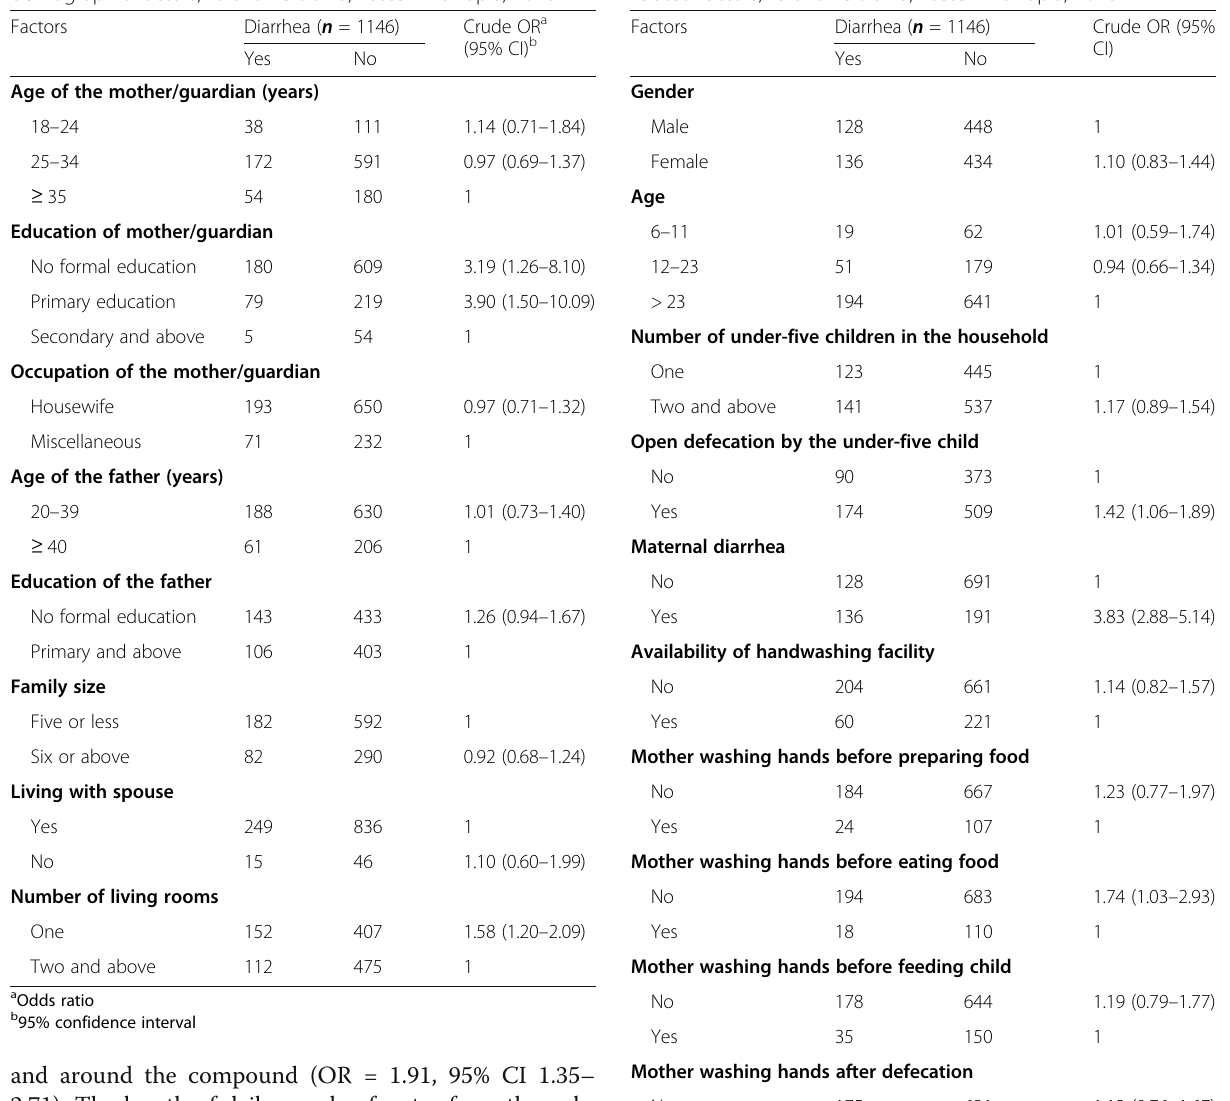
Table 2 Distribution of diarrheal disease in relation to socio- demographic factors, rural Dire Dawa, Eastern Ethiopia, 2018